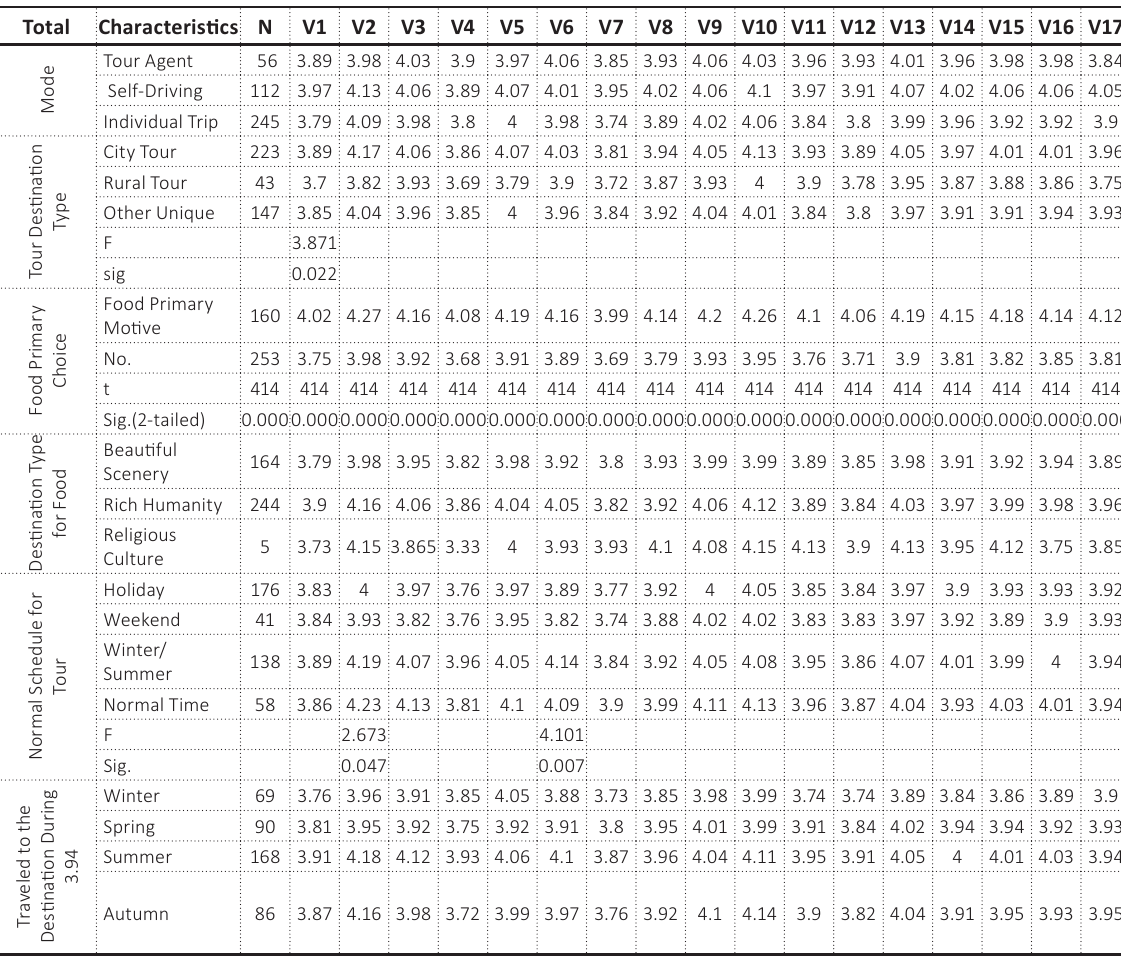
Figure 4. Attitude toward the importance of tourism Table 9. ANOVA and T-test results –